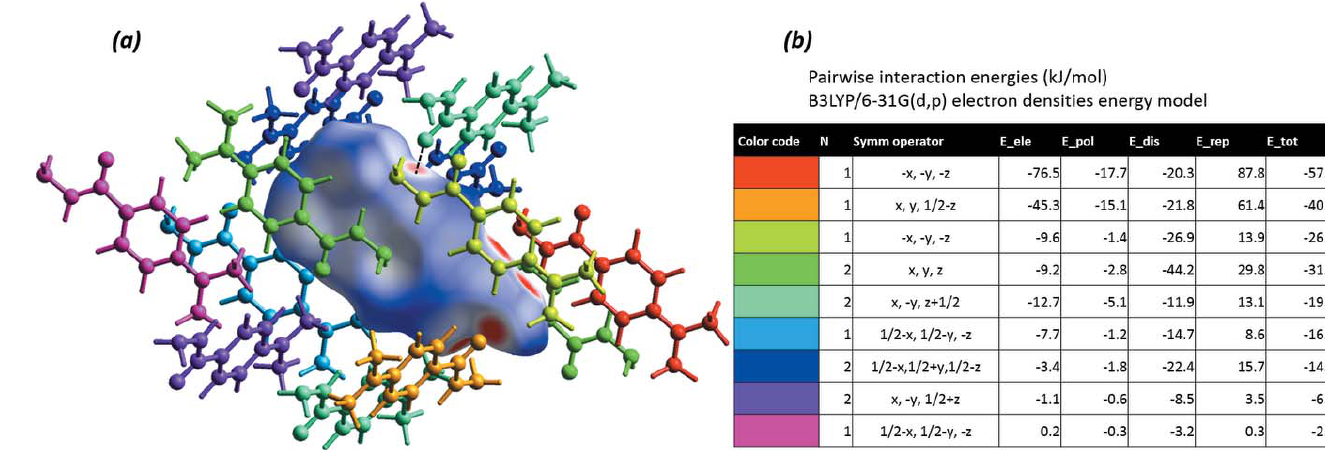
Figure 3 Interaction energies in crystal structure of ( I ). ( a ) Aview of interactions between a central molecule, shown as its Hirshfeld surface, and 13 molecules that share the interaction surfaces with the central molecule. Red areas on the Hirshfeld surface encode the closest intermolecular contacts, which are hydrogen bonds involving the hydrazido groups, a short C—H (cid:2)(cid:2)(cid:2) O type contact is shown as a dotted line; ( b ) Calculated energies (electrostatic, polarization, dispersion, repulsion, and total) of pairwise interactions between the central molecule and those indicated by respective colours.